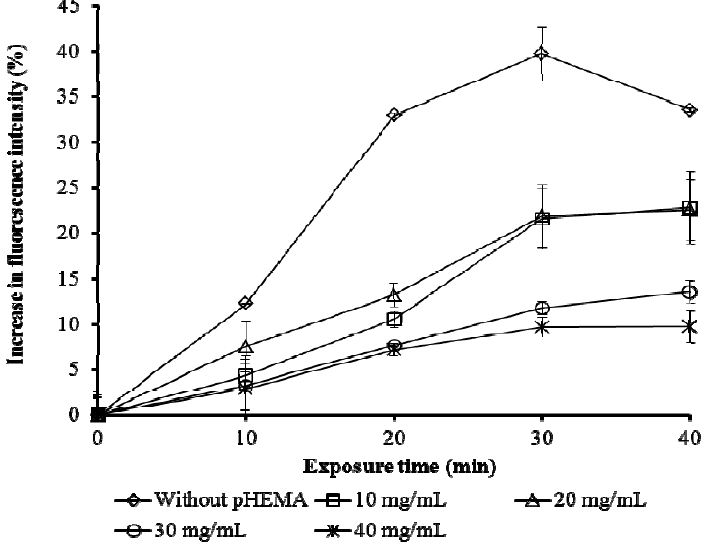
Figure 4. Exposure time of biosensor with different amount of pHEMA, with 10 µg/L of Cu.